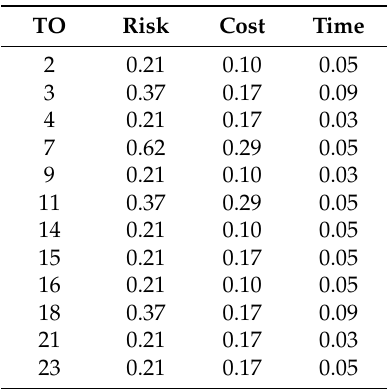
Table 6. Weighted and normalized matrix.